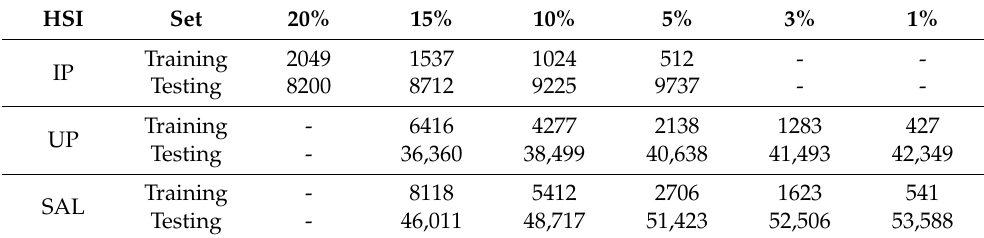
Table 9. Number of samples for training and testing